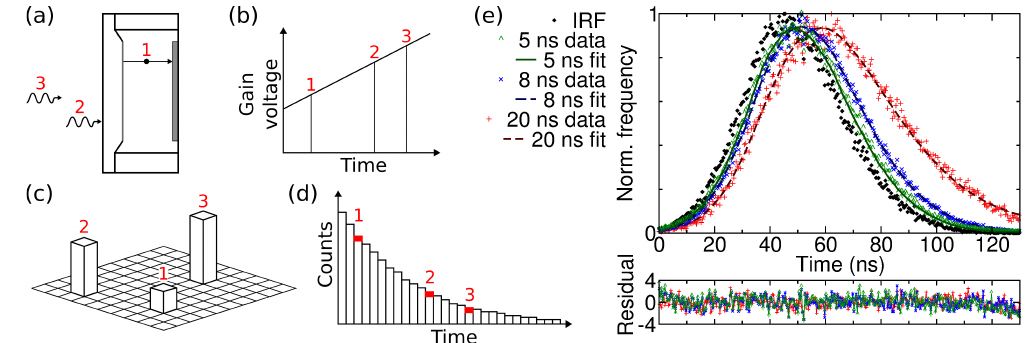
Figure 5. ( a – d ) Schematic of proposed gain sweep scheme. Photons arriving at different times during the CCD exposure ( a ) experience different gain voltage which is linearly swept in time ( b ); The pulse heights ( c ) can be converted to arrival times and added to the arrival time histogram ( d ); The gain sweep is repeated many times to build up a histogram for each pixel of the image; ( e ) Simulated fluorescence decays obtained from frames acquired at different acceleration voltages, and the instrument response function (IRF) obtained from measurement with the highest voltage (simulated time 0). The arrival time of each photon was found from its pulse height. Single-exponential fits to the decays yield decay times of 4.72, 8.78 and 20.27 ns for the 5, 8 and 20 simulated decays, respectively